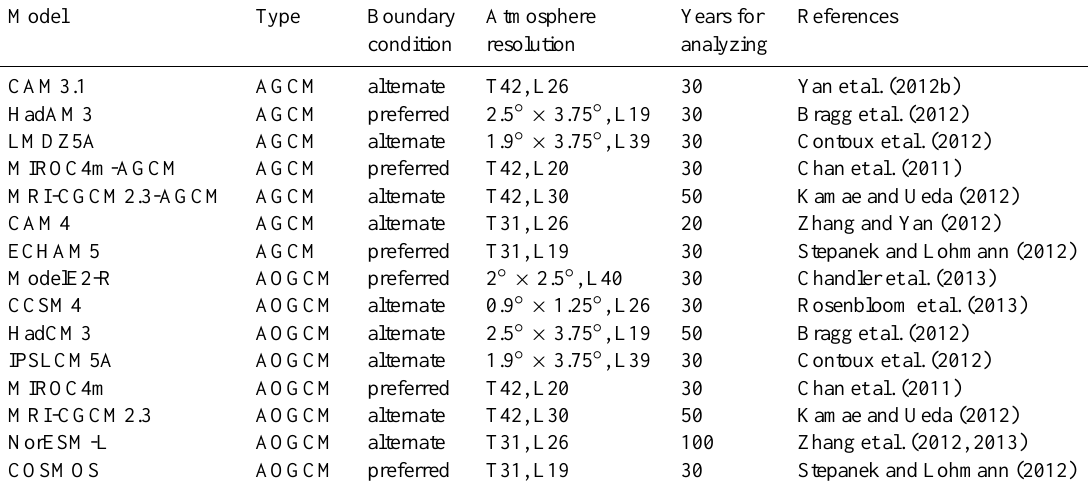
Table 1. Basic information of general circulation models used in this